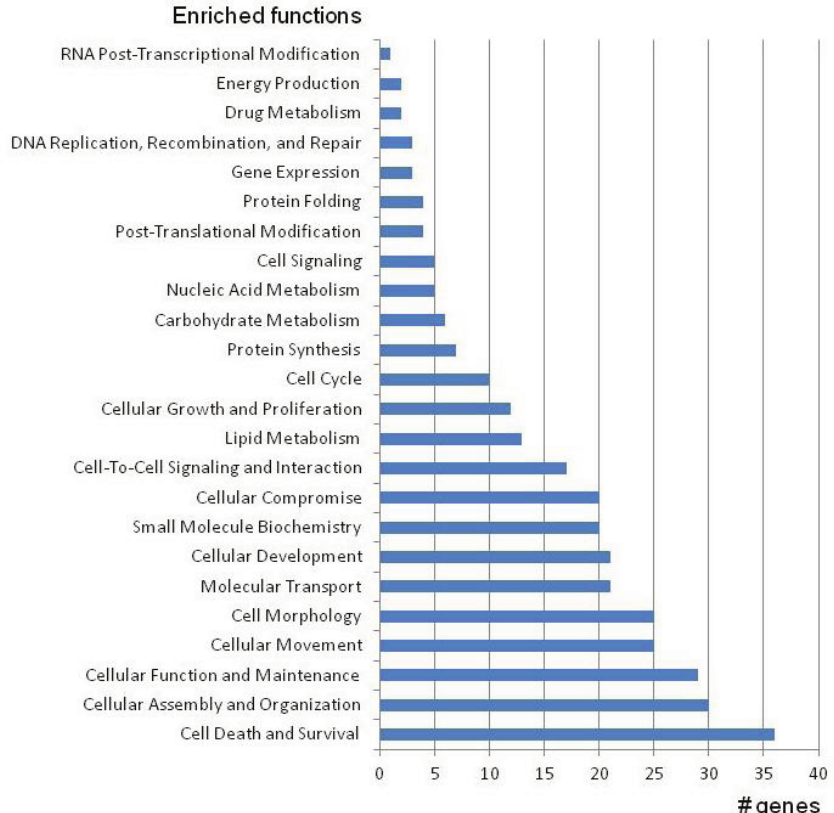
Figure 2. Functional categories containing enriched molecular and cellular functions of genes involved in CMT and related